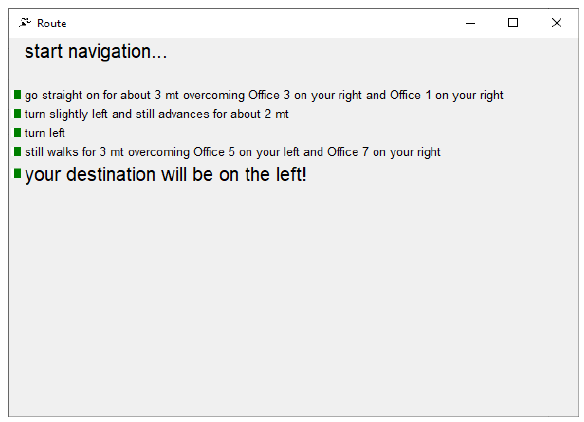
Figure 10. Indications window returned to the user hence, a user-friendly solution is essential for their success (Sakpere et al.,